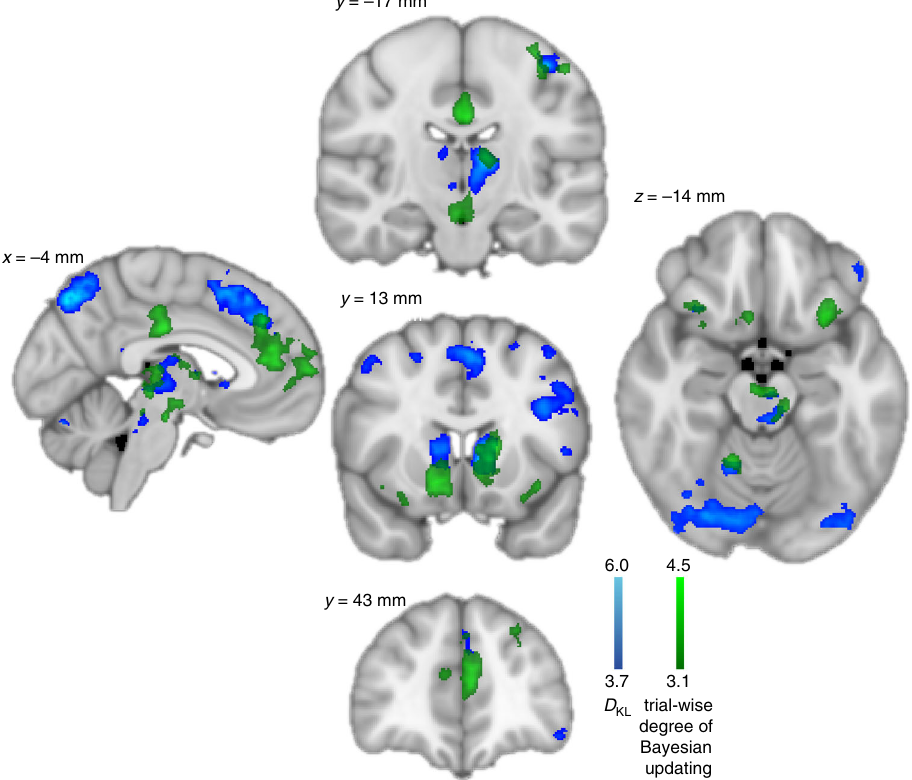
Fig. 4 Trial-by-trial analysis of the degree of ideal Bayesian updating. Green = signi fi cant positive effects for regressor Bayesianness , indicating regions where BOLD signals increased whenever belief updates were closer to Bayesian ideal updating. Notably, activity in ventral (right 14, 13, − 9 mm, z -score = 4.27) and dorsal striatum (left 14, 13, − 9 mm, z -score = 4.27), FPC ( − 4, 62, 9 mm, z -score = 4.05), anterior midcingulate cortex (aMCC, − 9, 36, 27 mm, z -score = 4.71), posterior cingulate cortex (PCC, − 1, − 19, 32 mm, z -score = 4.65) and midbrain overlapping with the substantia nigra (SN) and ventral tegmental area (VTA, − 2, − 12, − 12 mm, z -score = 3.80), was found to be higher whenever a participant ’ s update was closer to optimal. See Supplementary Table 1 for details about signi fi cant cluster activations. All these effects at least partly overlapped with main effects of D KL (reproduced as in Fig. 3, depicted in blue) despite whole brain FWER correction. Colour bars indicate z-scores, plots are cluster extent corrected at p <